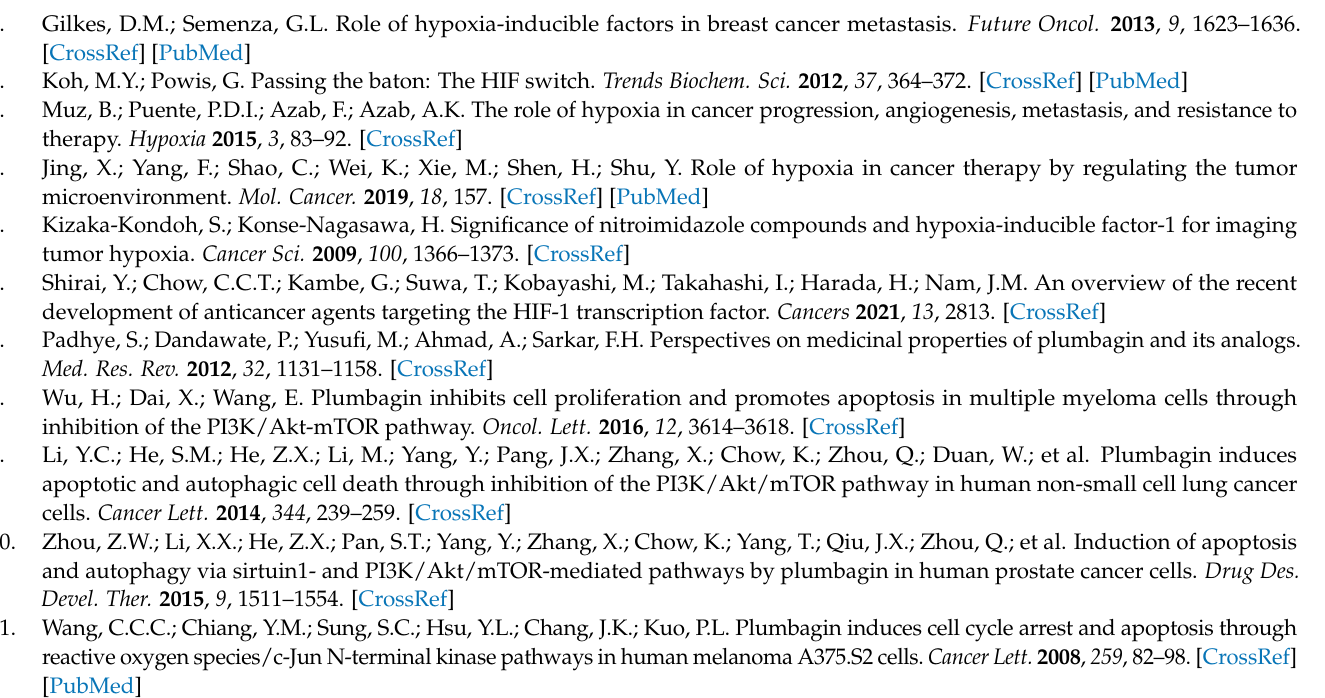
the protein expression of HIF-1 α and β -actin as shown in Figure 4A. Figure S2: Full-length blots representing the protein expression of VEGF and β -actin as shown in Figure 5C. Figure S3: Full- length blots representing the protein expression of PI3K/Akt/mTOR/HIF-1 α and β -actin as shown in Figure 6A. Table S1: List of primer sequences used for